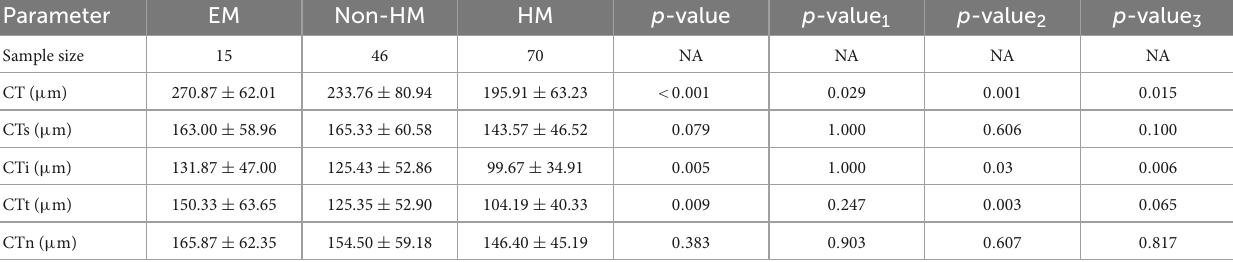
TABLE 3 Choroidal parameters in the participant’s right eye.